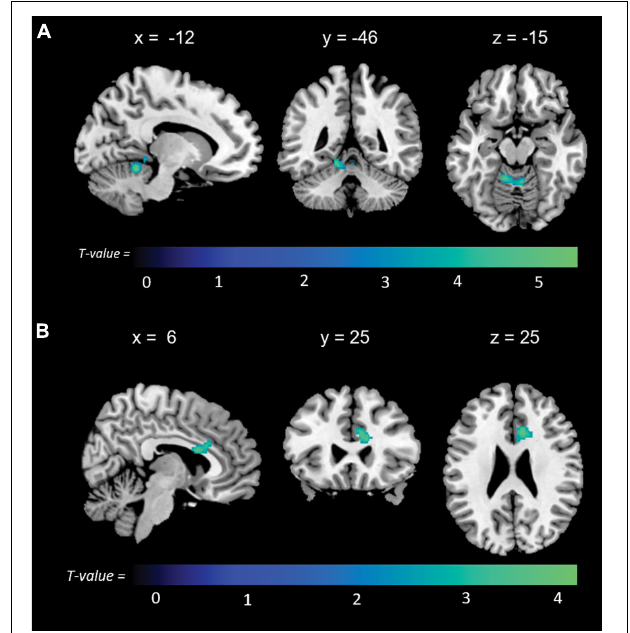
FIGURE 1 | Negative correlations between functional connectivity of the left fronto-parietal network (l-FPN) and (A) memory and (B) total anosognosia.